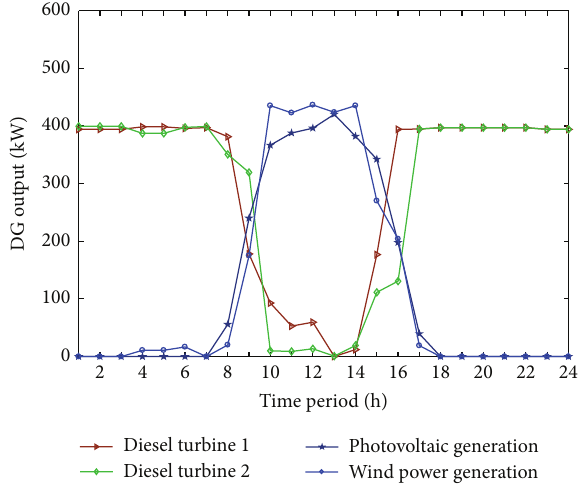
Figure 4: The optimized output of four DG units in 24 hours.